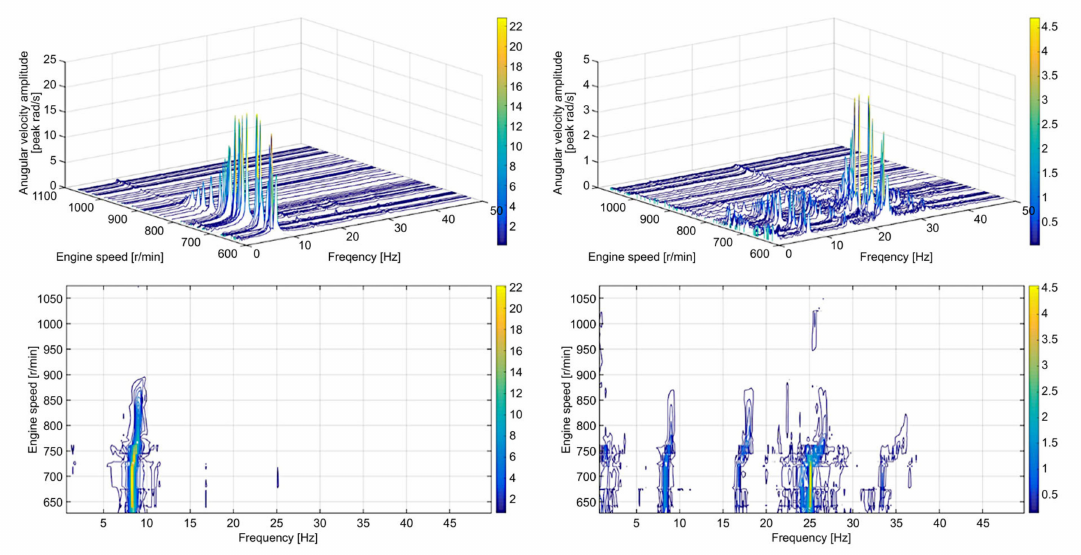
Figure 9. Frequency domain of angular velocity at flexible coupling during acceleration. Engine side (left); Shaft side (right).